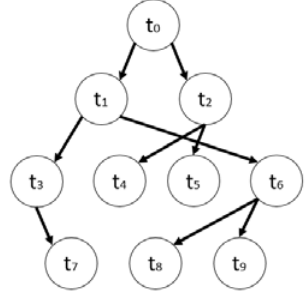
Figure 1. A directed cyclic task graph.